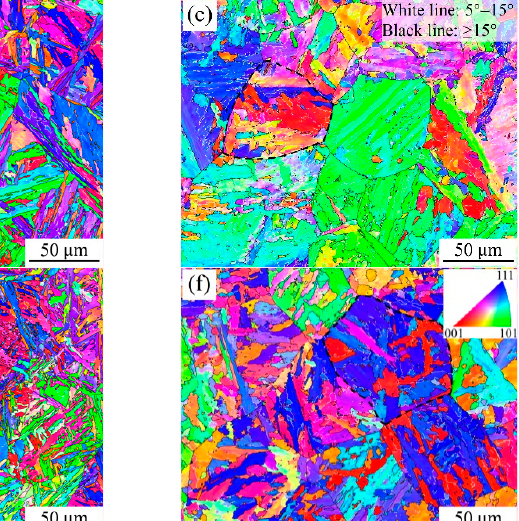
Figure 5. Boundary distributions of the simulated samples with 0.04 wt.% C ( a – c ) and 0.12 wt.% C ( d – f ) under the different heat inputs: ( a , d ) 10 kJ/cm, ( b , e ) 20 kJ/cm and ( e , f ) 50 kJ/cm. 3.3. Phase Transformation Mechanism and Correlation with Impact Toughness To display the effects of carbon content and heat input on the crystallographic struc- ture more clearly, the crystallographic packet and Bain zone on representative grains marked in Figures 4 and 5 are visualized in Figures 6 and 7, by highlighting with four (red, yellow, blue and green) and three (red, yellow and blue) colors, which correspond to four CP groups (close-packed groups, CP1–CP4) and three Bain groups (B1–B3), respec- tively. Moreover, the corresponding results from quantitative calculation of the length fraction of intervariant boundaries between V1 and the other variants in each sample are shown in Figure 8. It can be seen from the packet map (Figure 6) that the regular packets interactively split the entire austenite grains for LM and LB structures, while for GB struc-